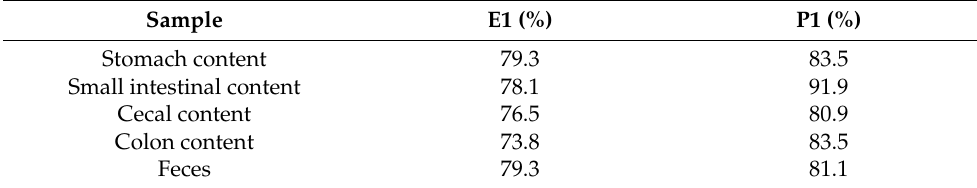
Table 3. Relative group strength of core microbiome families in trial 1.